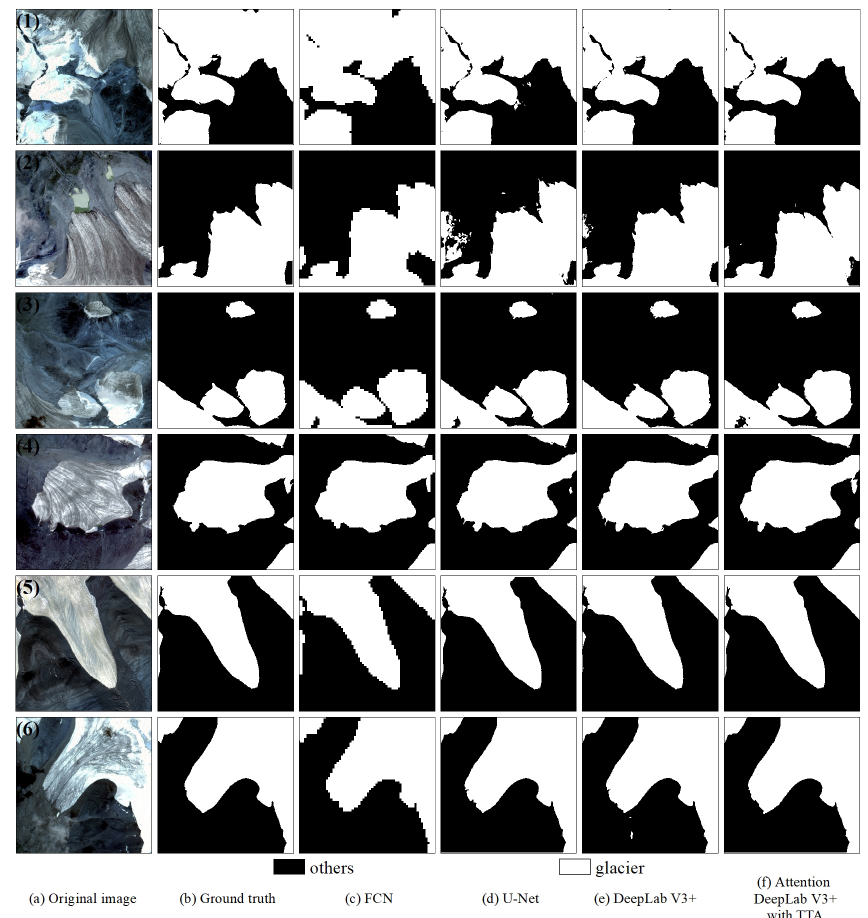
Figure 10. Comparison of test results of different